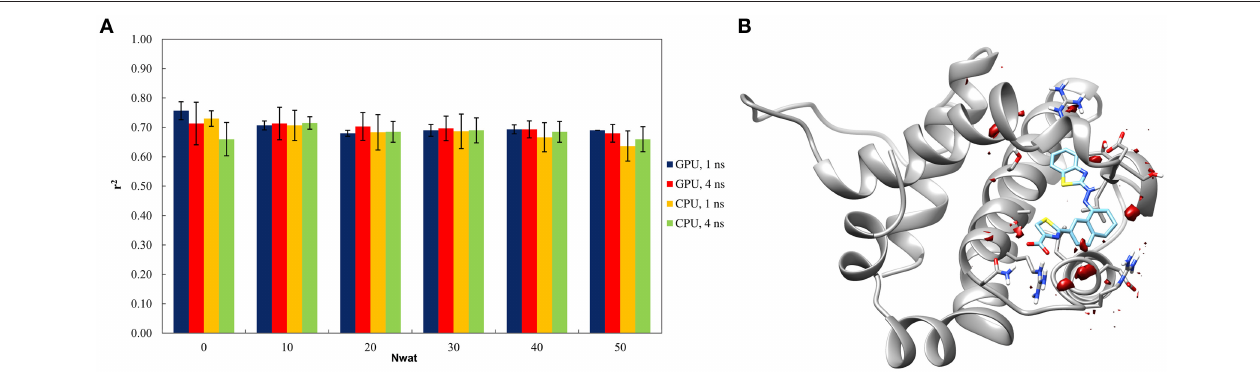
FIGURE 4 | (A) Trend of r 2 in dependency of Nwat for BCL-X L . (B) Water density plot obtained by grid analysis of BCL-X L -3ZC4 complex (visualization with Chimera, step = 1, level = 15).